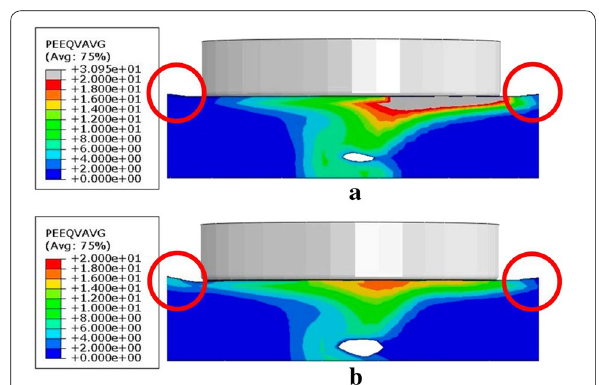
Figure 9 Deformation of the material and the presence of the void during FSW